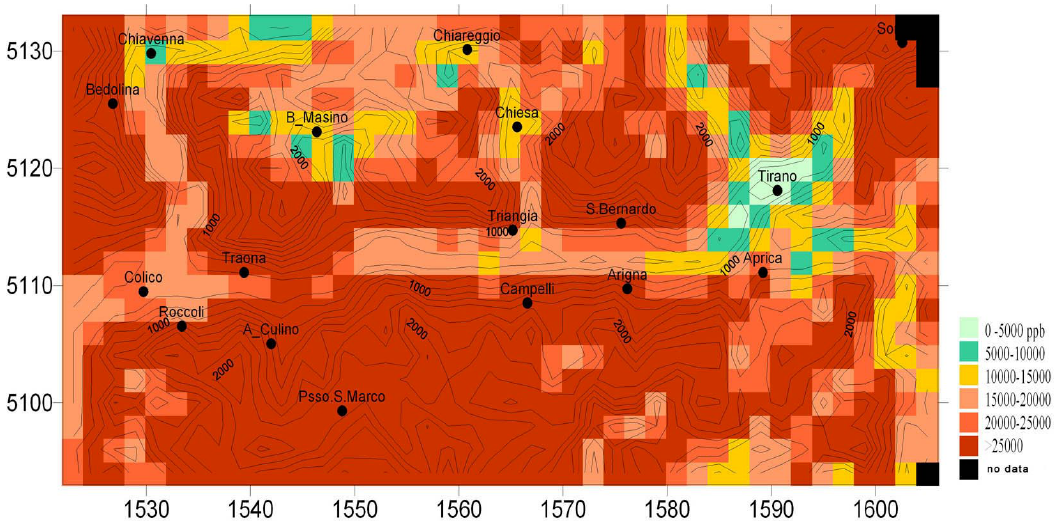
FIGURE 5. AOT40 distribution into the domain (uncorrected concentration data).